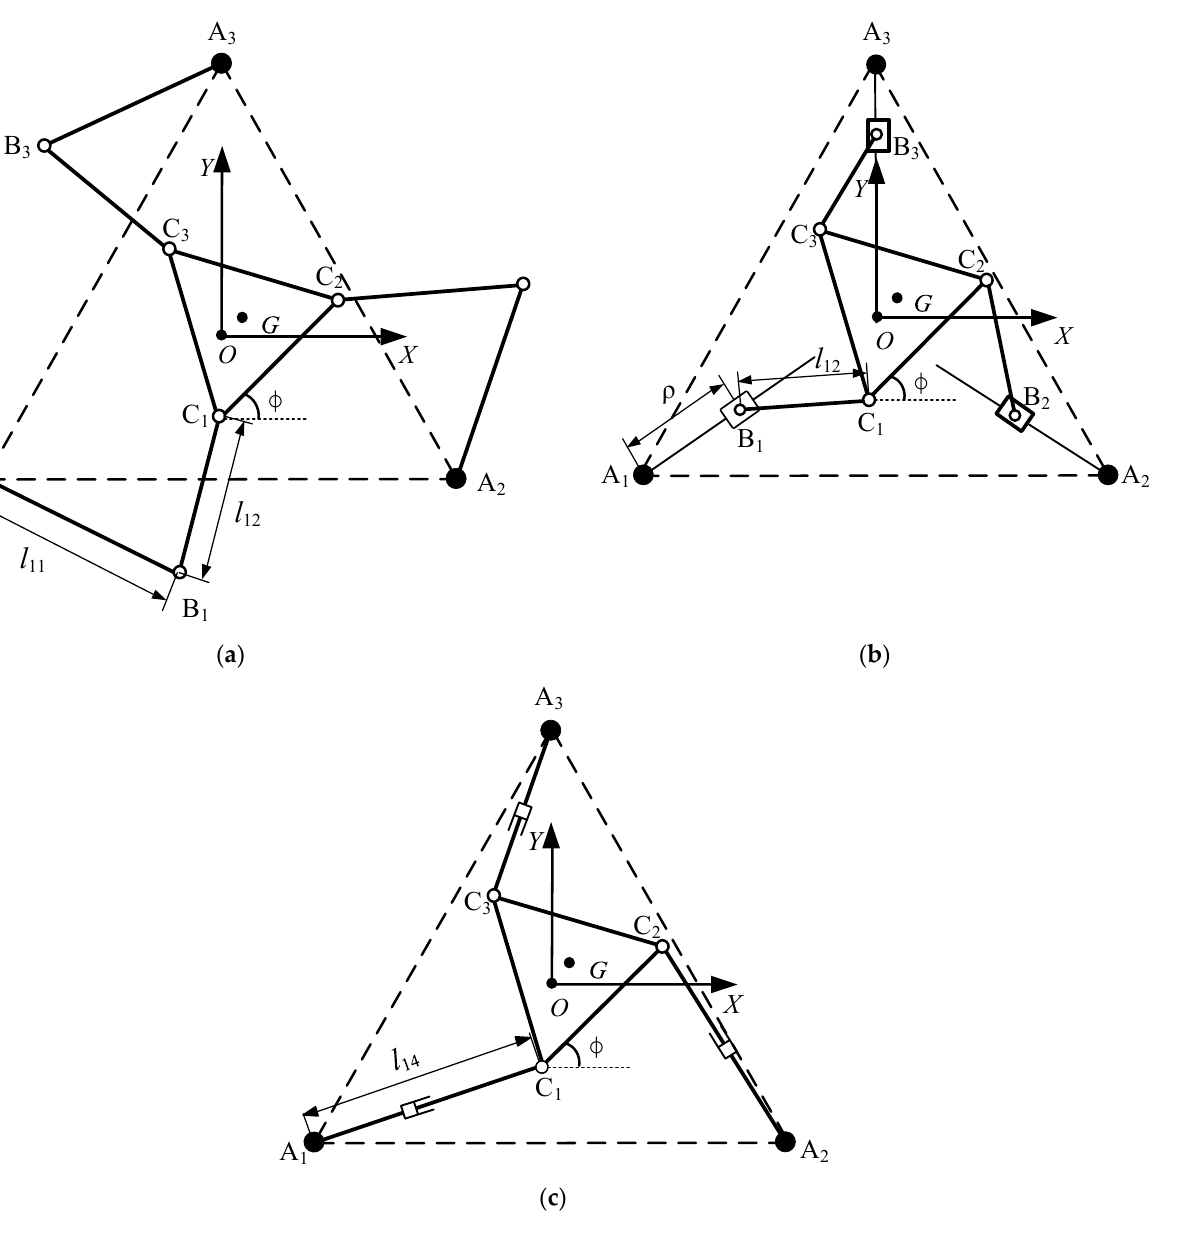
Figure 1. Coordinate system and manipulator architectures of three PPMs: ( a ) 3-RRR PPM, ( b ) 3-PRR PPM, ( c ) 3-RPR PPM.